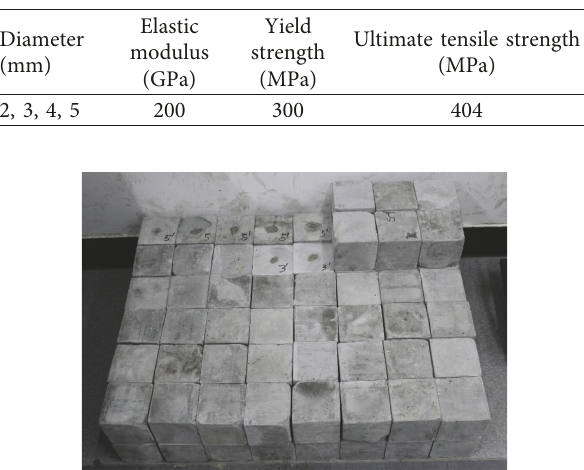
Figure 5: Concrete block samples used for shear tests.